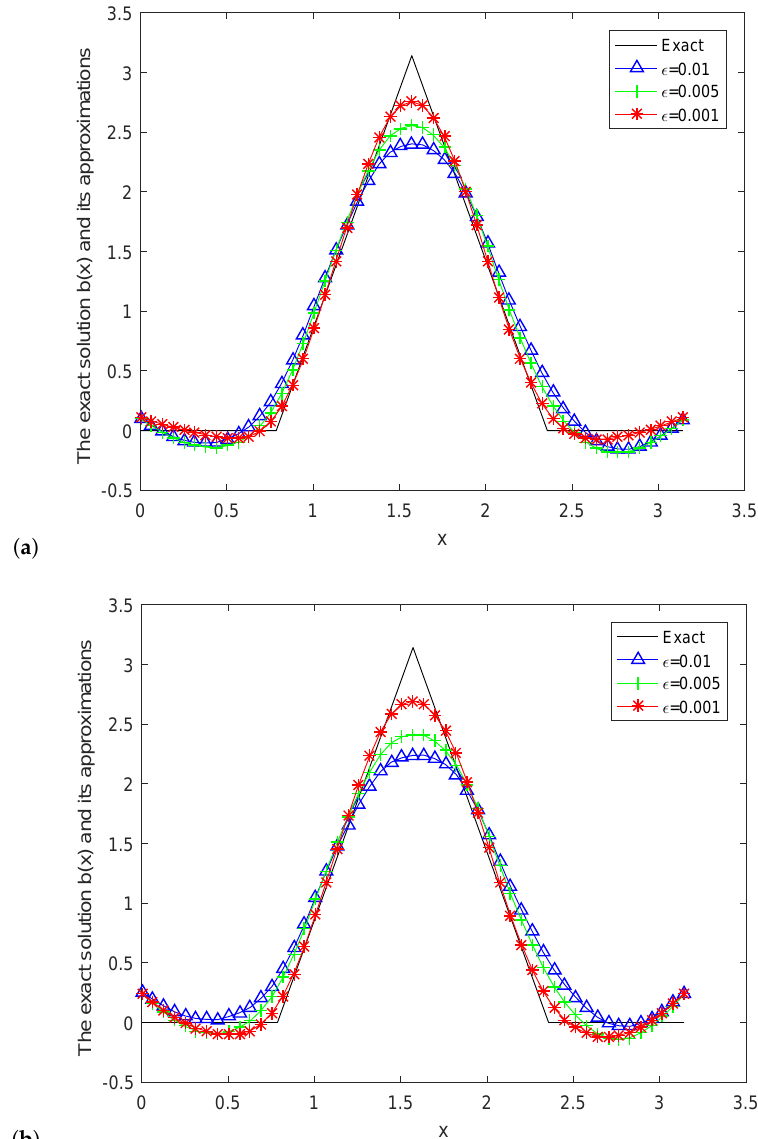
( x ) for Instance 5: ( a ) α = 1.2, ( b ) N 2